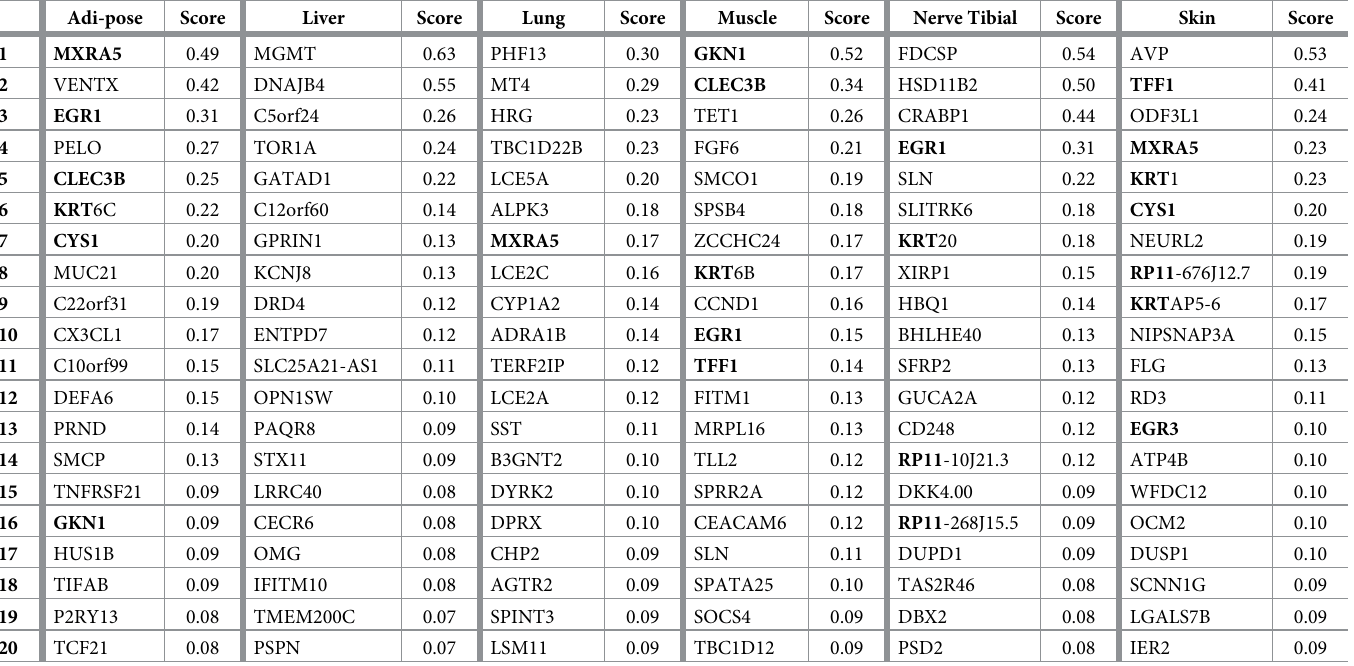
Table 4. Top 20 genes with highest importance SHAP scores in each